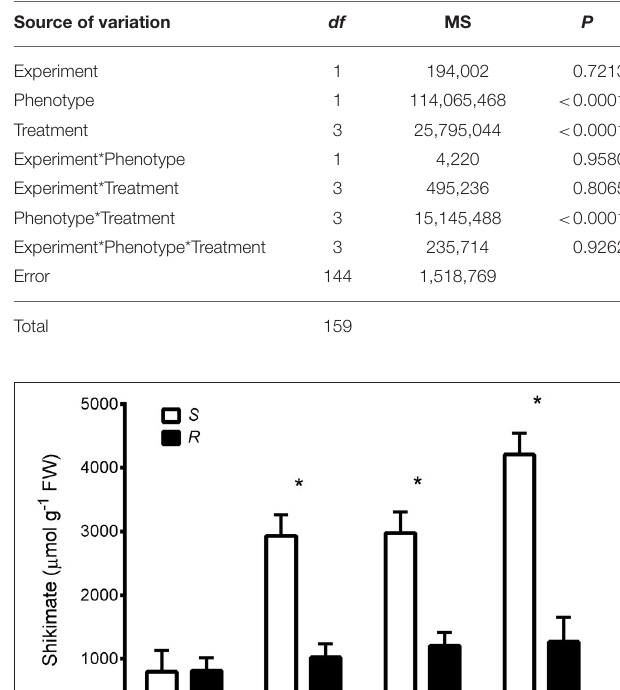
TABLE 1 | Summary of ANOVA: mean square (MS), degrees of freedom (df), and probability values (P) for the effect of replication of the experiment comparing the effect of Lolium perenne phenotype (glyphosate-susceptible and -resistant phenotypes), treatment (dose of glyphosate: 0, 500, 1,500, and 3,000 g ae ha − 1 ) and their interaction on shikimate concentration.